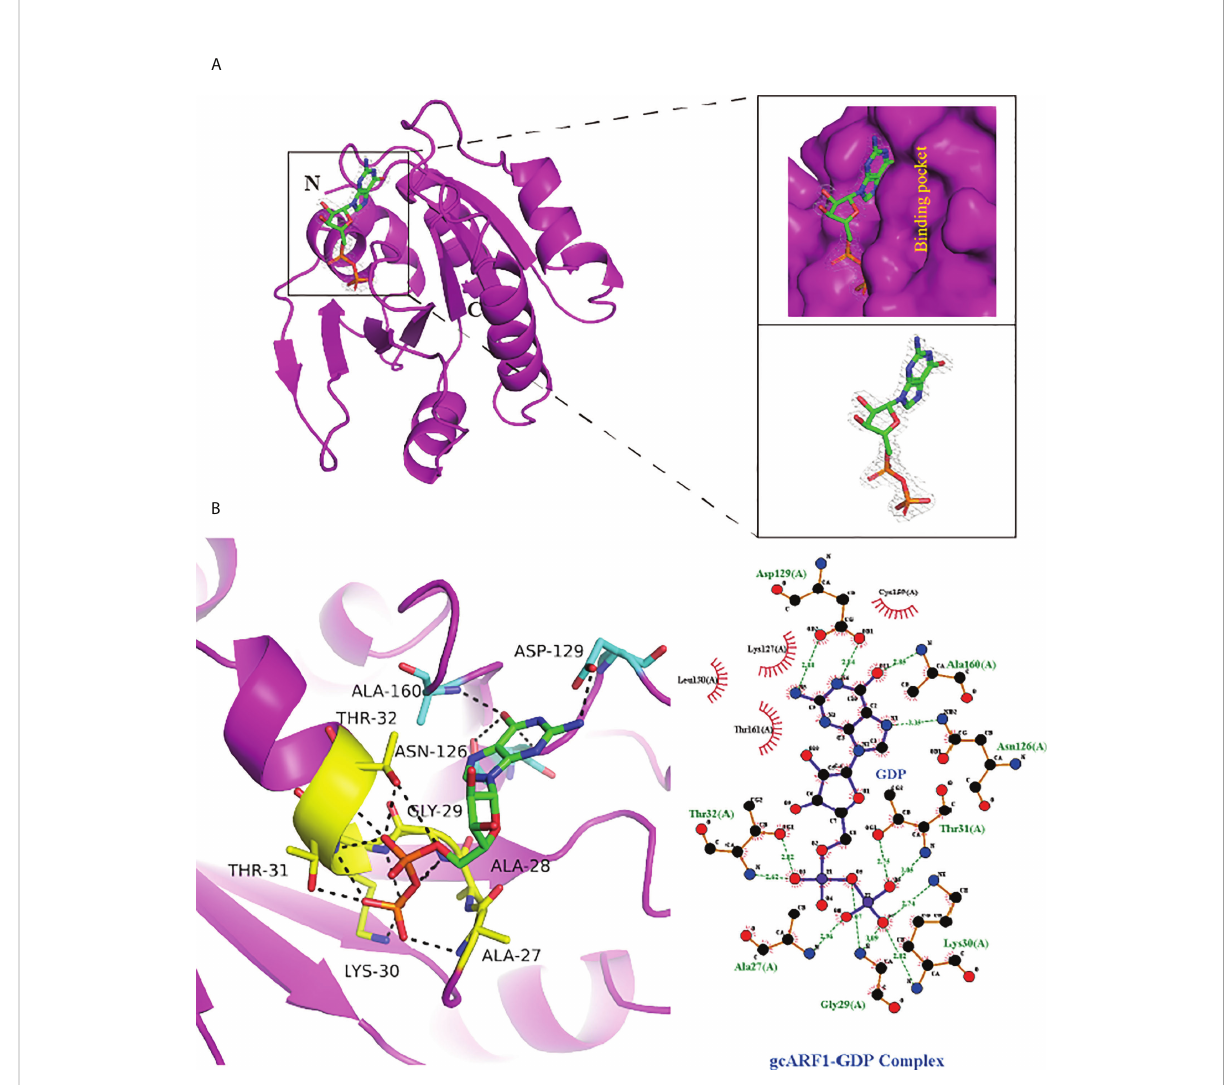
FIGURE 5 Structural analysis of gcARF1-GDP complex. (A) The GDP combinative pocket of gcARF1. The surface diagram is shown in the upper right, and the GDP electron density shown in the lower right (level = 2.0). (B) The hydrogen bond interaction between GDP and gcARF1. Left: The GDP is shown as green sticks, the AAGKTT motif shown as yellow sticks, the N 126 , D 129 and A 160 shown as cyan sticks, and the hydrogen bonds shown as black dotted line. Right: The interaction between gcARF1 and GDP analyzed by LigPlus